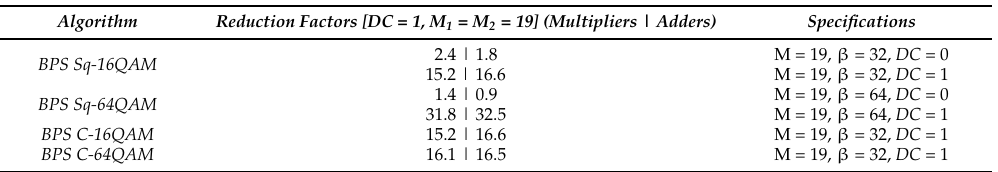
Table 3. Computational complexity reduction factors relative to two-stage n-PSK partitioning algorithm employing optimal decision boundaries in the symbol decision circuit